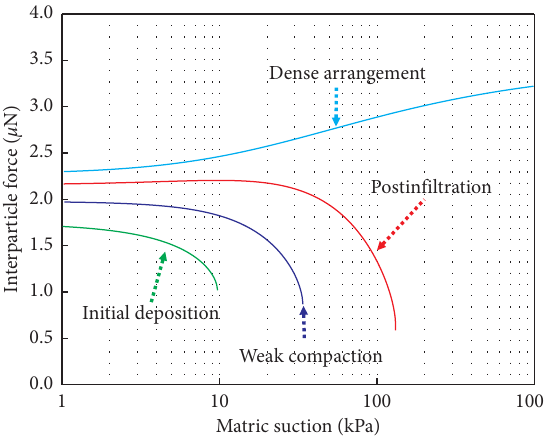
Figure 10: The change of interparticle force with matric suction in different states.